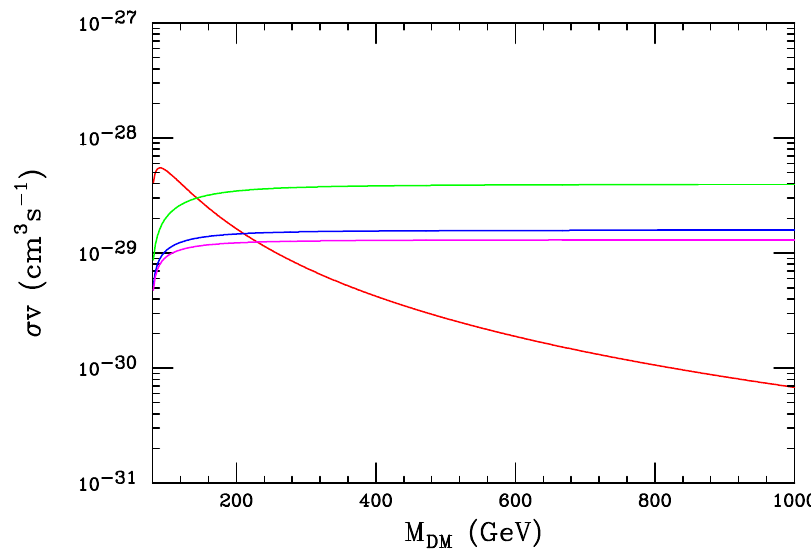
Figure 2 . Higgs-mediated pair annihilation cross section scaled by the relative DM velocity as a function of the DM mass; note that this cross section is not thermally averaged. The red curve corresponds to the case of scalar dark matter, S , for the speci(cid:12)c process SS ! h ! W + W (cid:0) , with ~ (cid:21) = 10 (cid:0) 2 (as discussed in the text). The green (blue, magenta) curves are for the analogous vector DM annihilation channel assuming an e(cid:11)ective coupling of 10 (cid:0) 2 as described in the text. Here the heavier scalar mass is assumed to be 3(5 ; 7) m DM ,